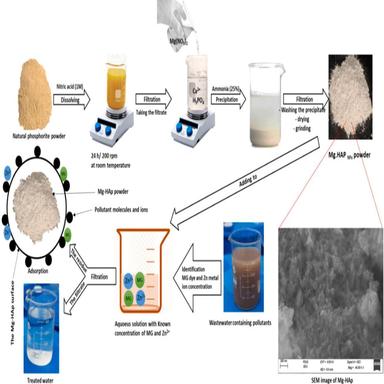
Schematic of the synthesis of Mg-doped hydroxyapatite nanofibers (Mg.HAPNFs) from natural phosphorite.